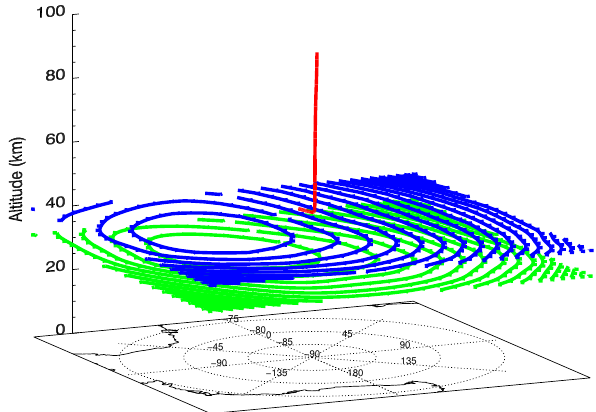
Figure 5. GROGRAT ray-tracing results for the 19 August 2004 wave shown in Fig. 4 (right) projected in three dimensions over Antarctica. The two contours represent geopotential heights at 3mbar (blue) and 10mbar (green), and show the wave ray path (red